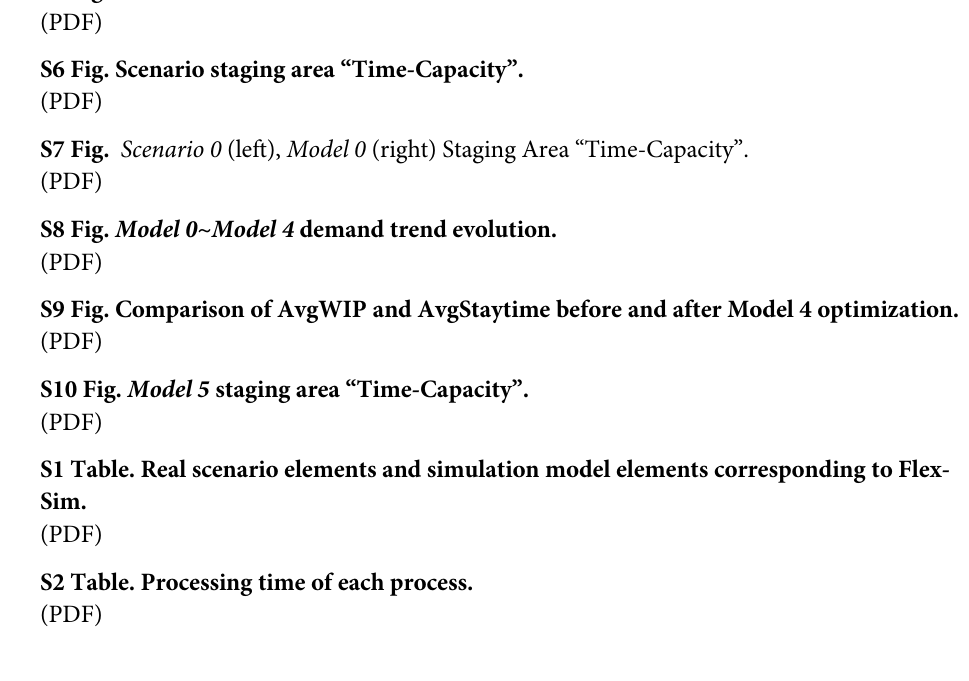
S5 Fig. Production line scenario simulation model. (PDF) S6 Fig. Scenario staging area “Time-Capacity”. (PDF) S7 Fig. Scenario 0 (left), Model 0 (right) Staging Area “Time-Capacity”. (PDF) S8 Fig. Model 0 ~ Model 4 demand trend evolution. (PDF) S9 Fig. Comparison of AvgWIP and AvgStaytime before and after Model 4 optimization. (PDF) S10 Fig. Model 5 staging area “Time-Capacity”. (PDF) S1 Table. Real scenario elements and simulation model elements corresponding to Flex- Sim. (PDF) S2 Table. Processing time of each process.